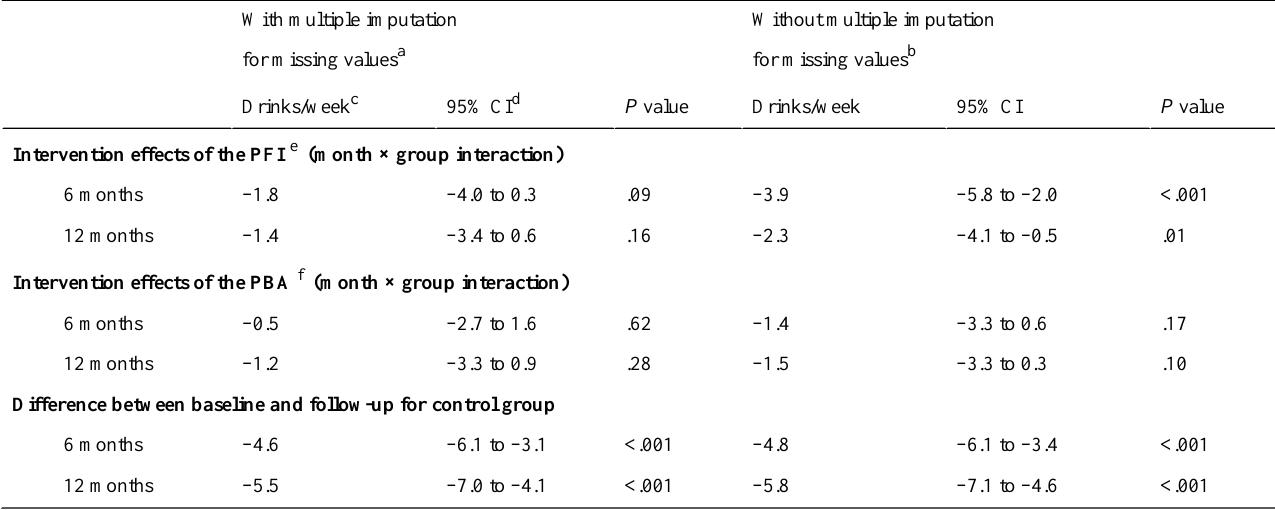
Table 4. Intervention effects on drinks/week based on random intercept model with and without imputation for missing